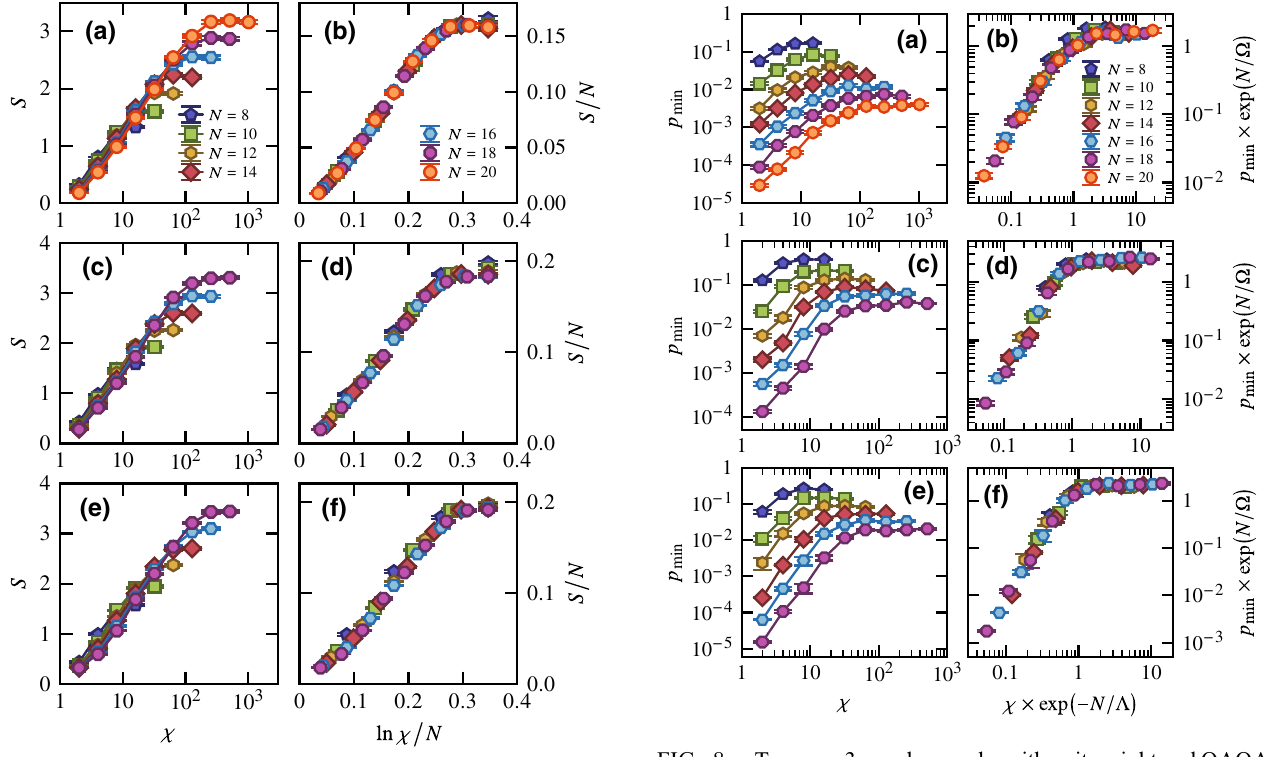
FIG. 7. Top row: 3-regular graphs with unit weight and QAOA depth p = 1. Middle row: 3-regular graphs with unit weight and QAOA depth p = 2. Bottom row: complete graphs with uniform random weight w ij ∈ [0, 1] and QAOA depth p = 4. Left col- umn: the average bipartite von Neumann entanglement entropy S from a cut in the middle of the MPS versus the bond dimension χ . Right column: the average bipartite von Neumann entangle- ment entropy S from a cut in the middle of the MPS rescaled by the system size N versus the rescaled variable ln χ/ N .